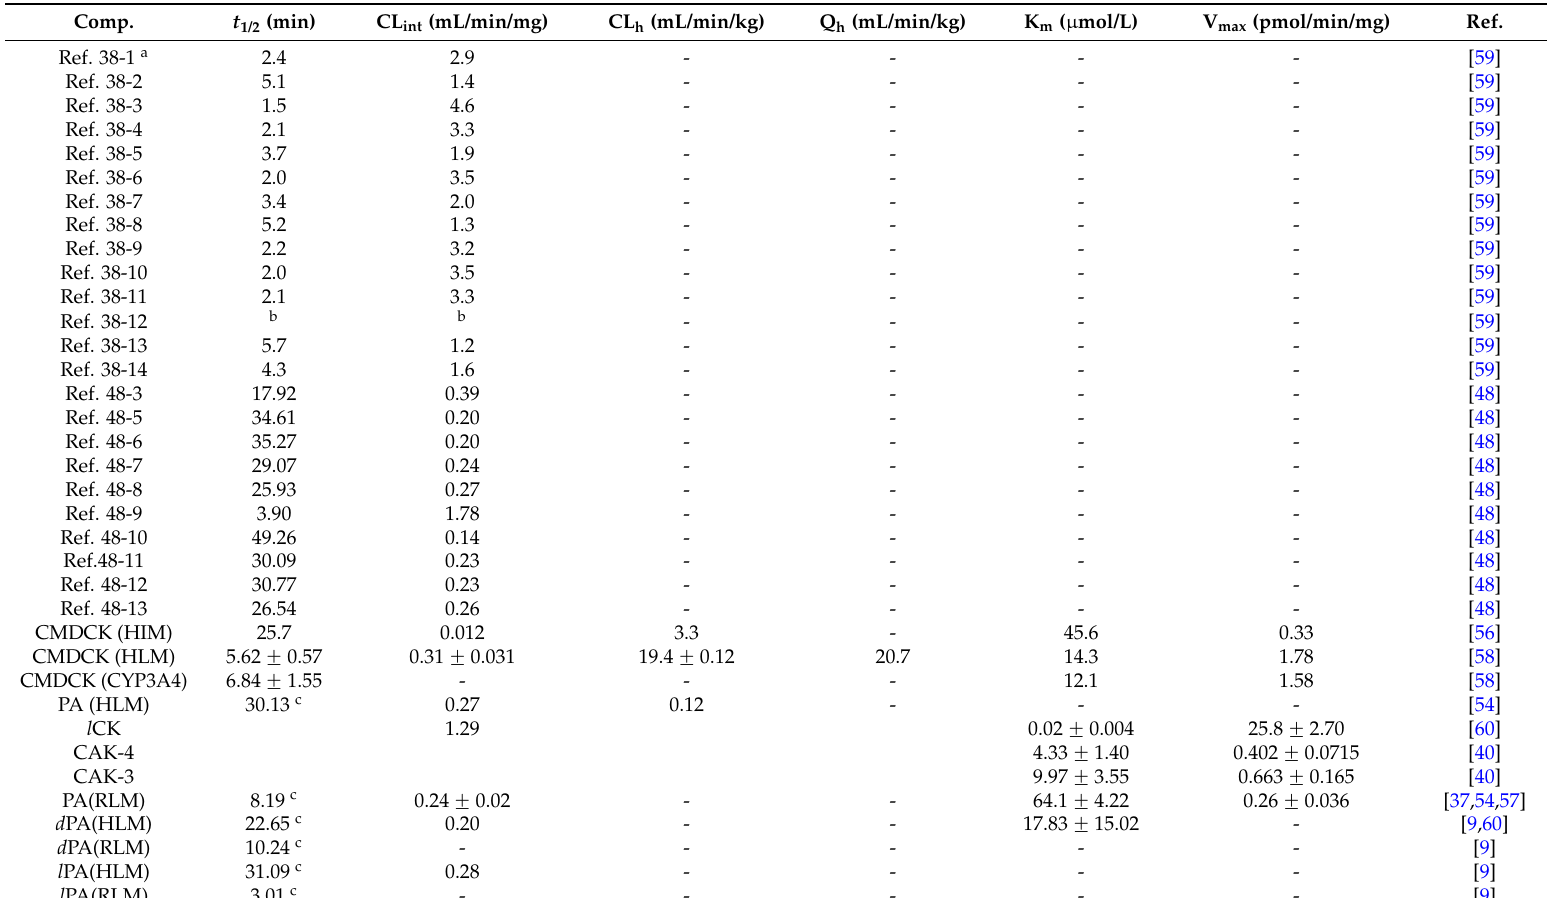
Table 3. Kinetic parameters of khellactone derivatives in vitro